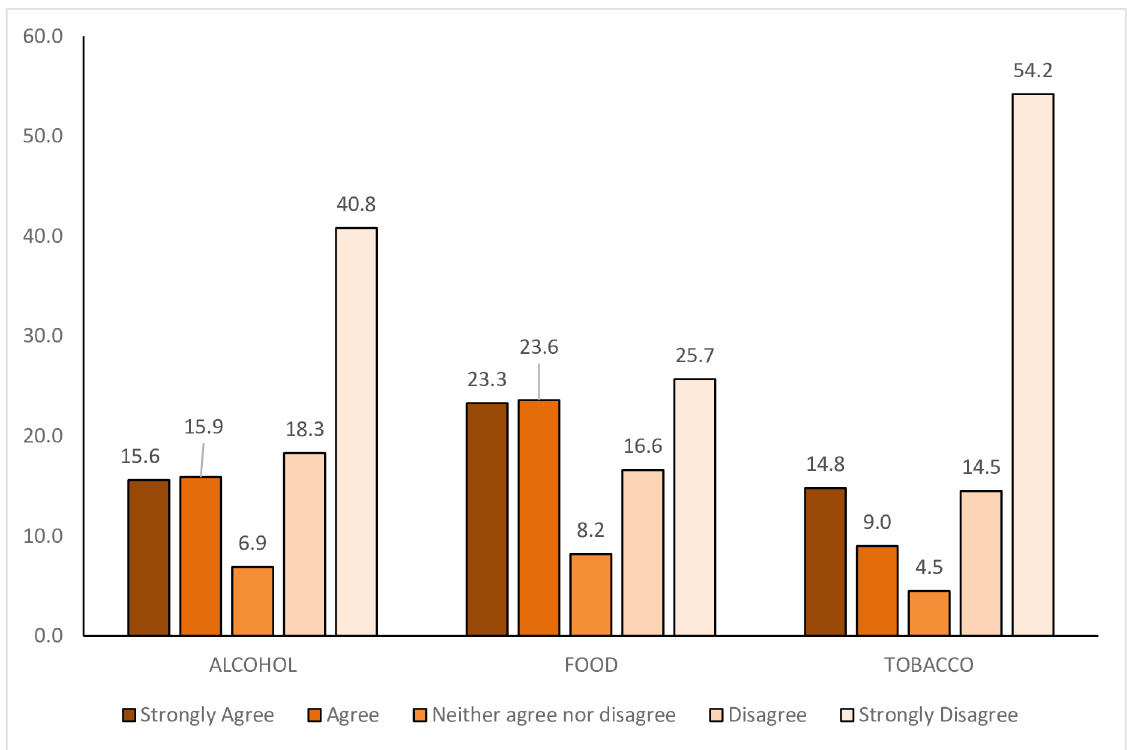
Fig 3. Level of agreementwith the statement. “Enablingthe active participationof all key stakeholders, including this industry, is vital to effective health governance” regardingAlcohol, Food, and Tobacco (percentageof respondents choosingeach category).